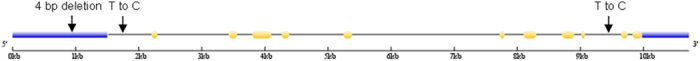
Structure and mutations of Csa2M058670.1 in different fruit flesh thickness cucumber lines.The gene structure was drawn by the online tool GSDS 2.0 (gene structure display server). Exons are shown by yellow boxes, introns are shown by black lines, and the upstream 1500-bp cis-promoters are shown by blue boxes. The gene structure is for four thick fruit flesh lines (D8, SPD01, DPD01 and 110). The mutation types in the thin fruit flesh cucumber lines are indicated by arrows. The 4-bp deletions in the promoter region occurred in four thin fruit flesh lines (XUE1, Pepino, Jin5–508 and EP6392). The middle “T” to “C” mutation types occurred in three thin fruit flesh lines (XUE1, Pepino and Jin5–508). The right “T” to “C” mutation types occurred in two thin fruit flesh lines (XUE1 and Pepino).